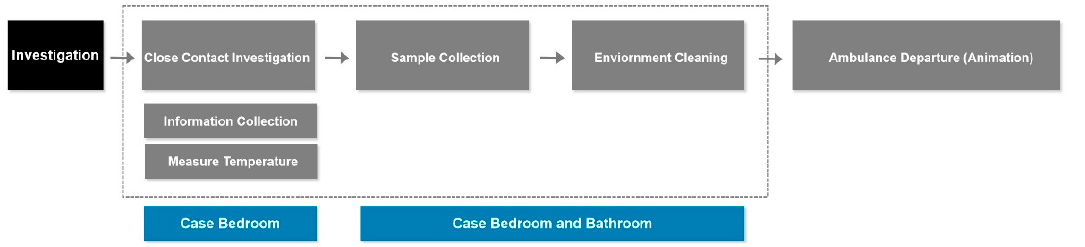
Figure 12. Investigation Module Exploring Flow.